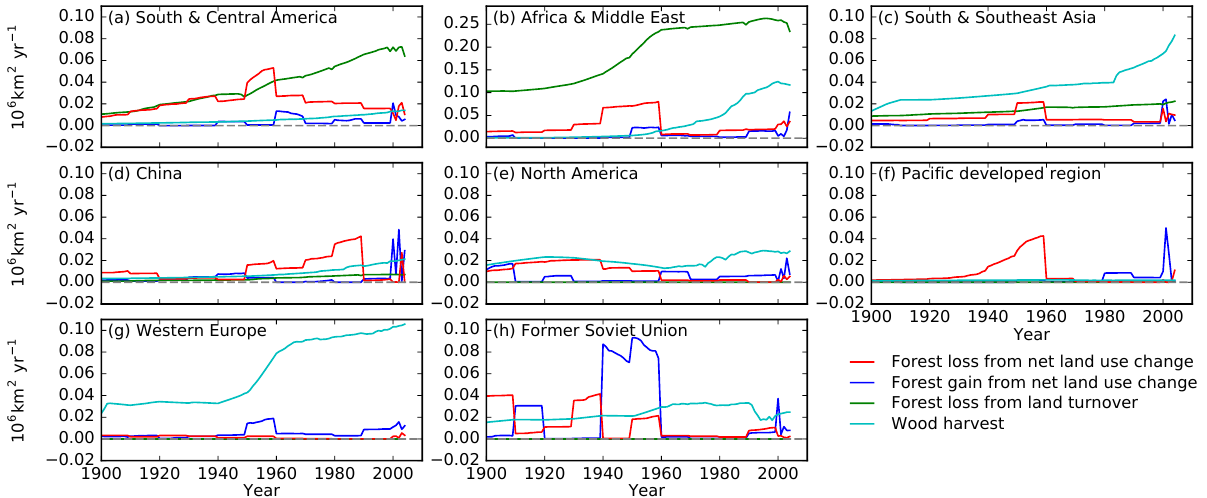
Figure 5. Annual regional areas subject to land use change. Only land use change activities involving forests are assumed to have dominant impacts on E LUC and are thus shown here: forest loss (red line) and gain (blue line) from net land use change, occurring within the same region but not in the same model grid cell; forest involved in land turnover (green line) and wood harvest (cyan line), where forested land remained a forest after land use change. Note that the scale of the y axis in (b) is different from the others. See Fig. 4 for the spatial extents of different